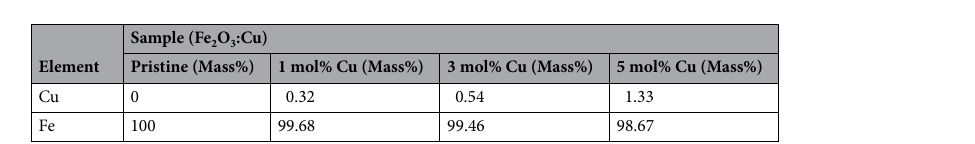
Table 1. XRF elemental analysis of pristine and Cu doped Fe 2 O 3 films.